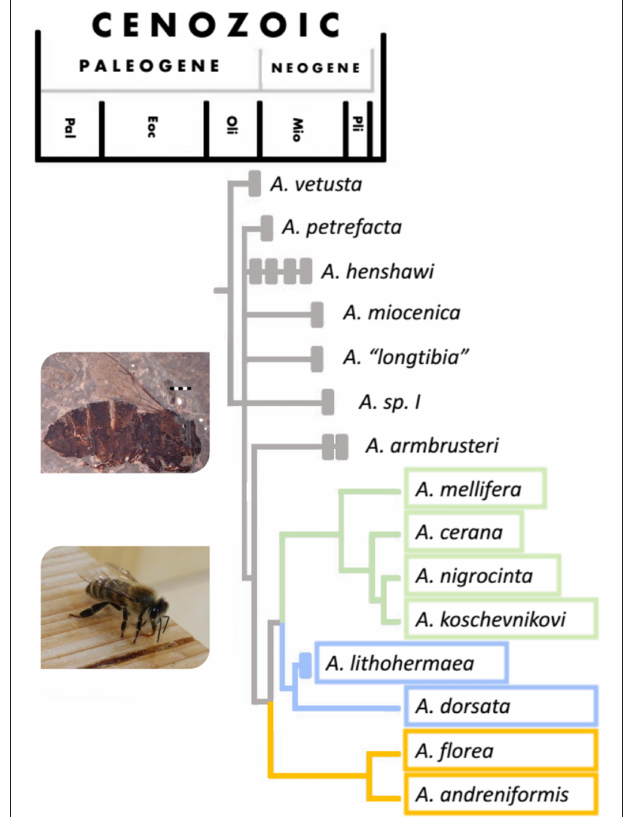
FIGURE 2 | Phylogeny of the Apis genus with timeline (figure adapted from Engel, 2006). For a more recent phylogeny see Raffiudin and Crozier (2007) . Solid bars show periods from which major fossils have been found. Species whose timeline finishes with a solid bar are extinct. Colors relate to nesting/dancing behavior of the groups: green—cavity nesting, vertical dancing species, blue—open nesting, vertical dancing species and orange—open nesting, horizontal dancing species. Images show a fossilized honey bee found in Randeck Maar ( Apis armbrusteri Zeuner) (Scale bar = 2mm. Photo from Kotthoff et al., 2011) and an Apis mellifera